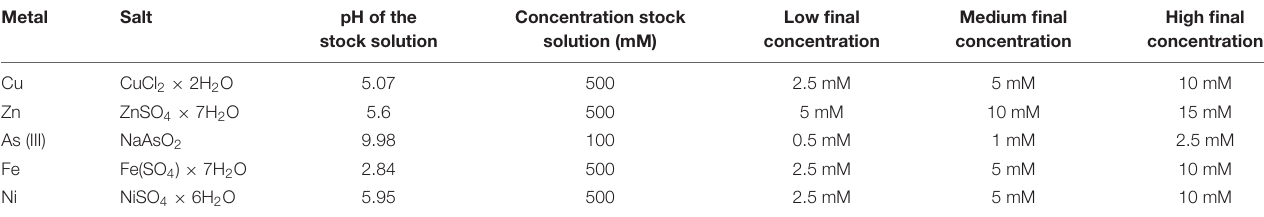
TABLE 1 | List of metal used in the experiment, from Chiellini et al. (2020). Metal